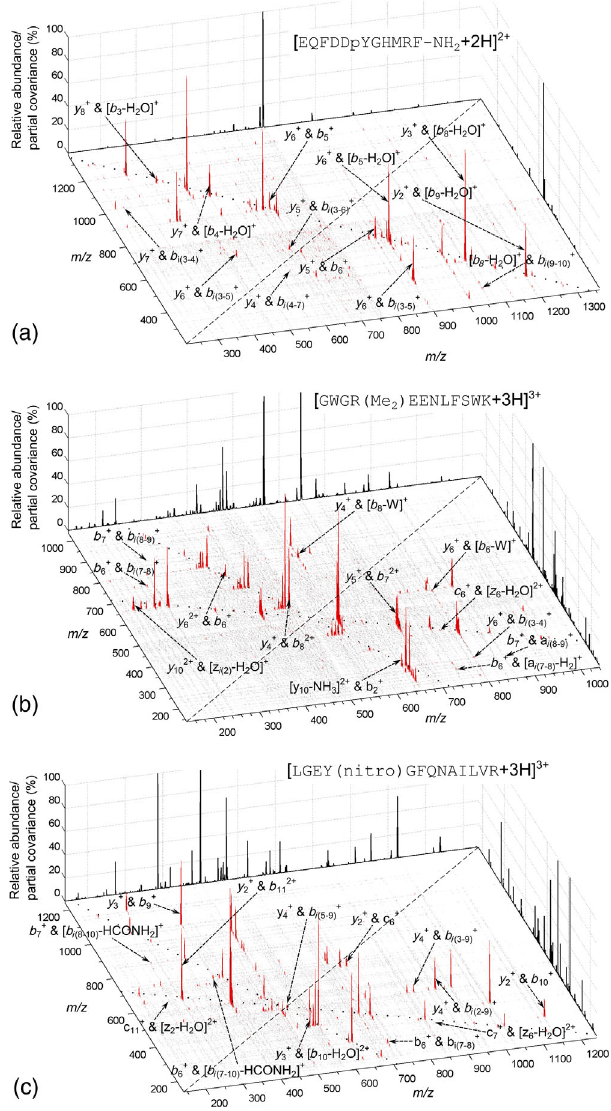
FIG. 4. Examples of 2D-PC-MS maps of protonated peptides. A nonexhaustive selection of top scoring 2D-PC-MS fragment- fragment correlation signals are labeled on each map, including very weak signals corresponding to the true (intrinsic) fragment correlations revealed by the 2D-PC-MS scoring; see Eq. (C1). Signal annotation is as in Fig. 3. It is a general property of 2D-PC- MS that it can reveal structurally informative signals even when the corresponding 1D spectrum is dominated by parent ion neutral loss [see panel (a) and also Fig. S7 in the Supplemental Material [30] ]. Mass conservation lines are shown by dotted lines. Autocorrelation signals are removed and the autocorrela- tion diagonals are shown by